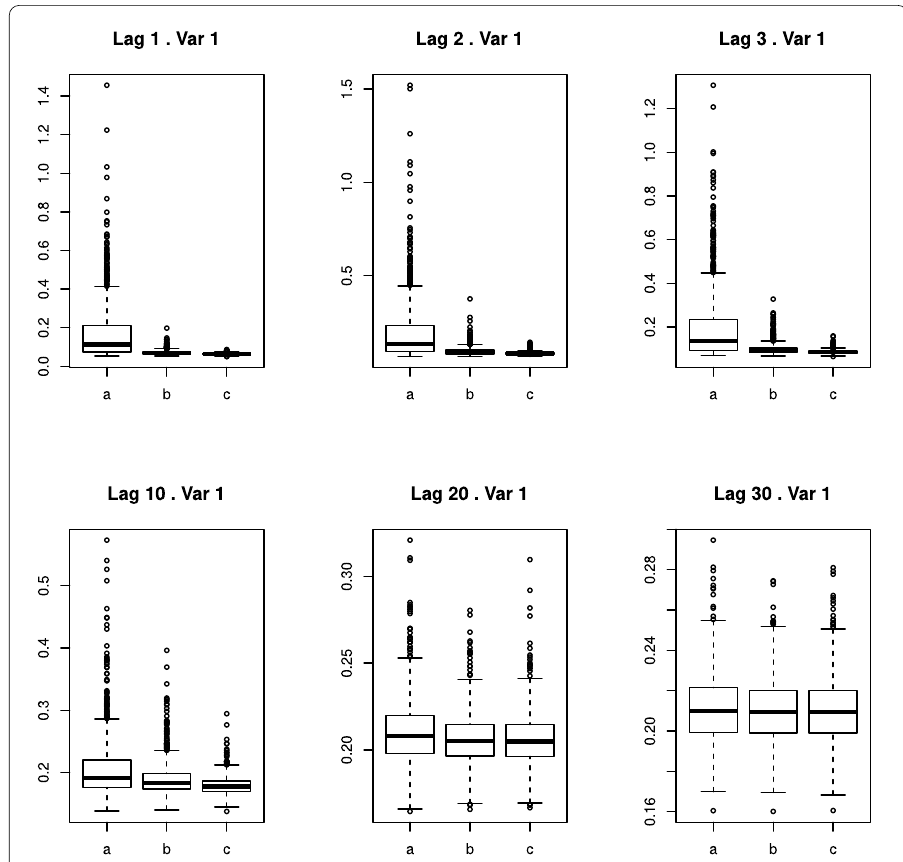
Figure 3 Boxplots of the prediction errors obtained with three predictors for the pure VAR model. ( a ) nonparametric predictor for each component independently, ( b ) semiparametric predictor for each component independently and ( c ) semiparametric predictor with VAR modelling of the